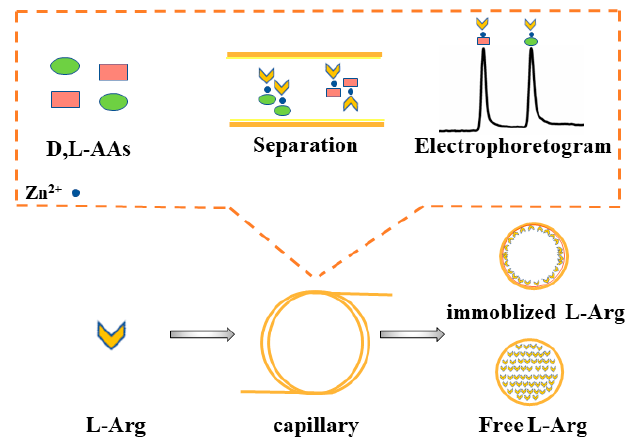
Figure 6. The possible mechanism of the CLE-CEC enantioseparation process.